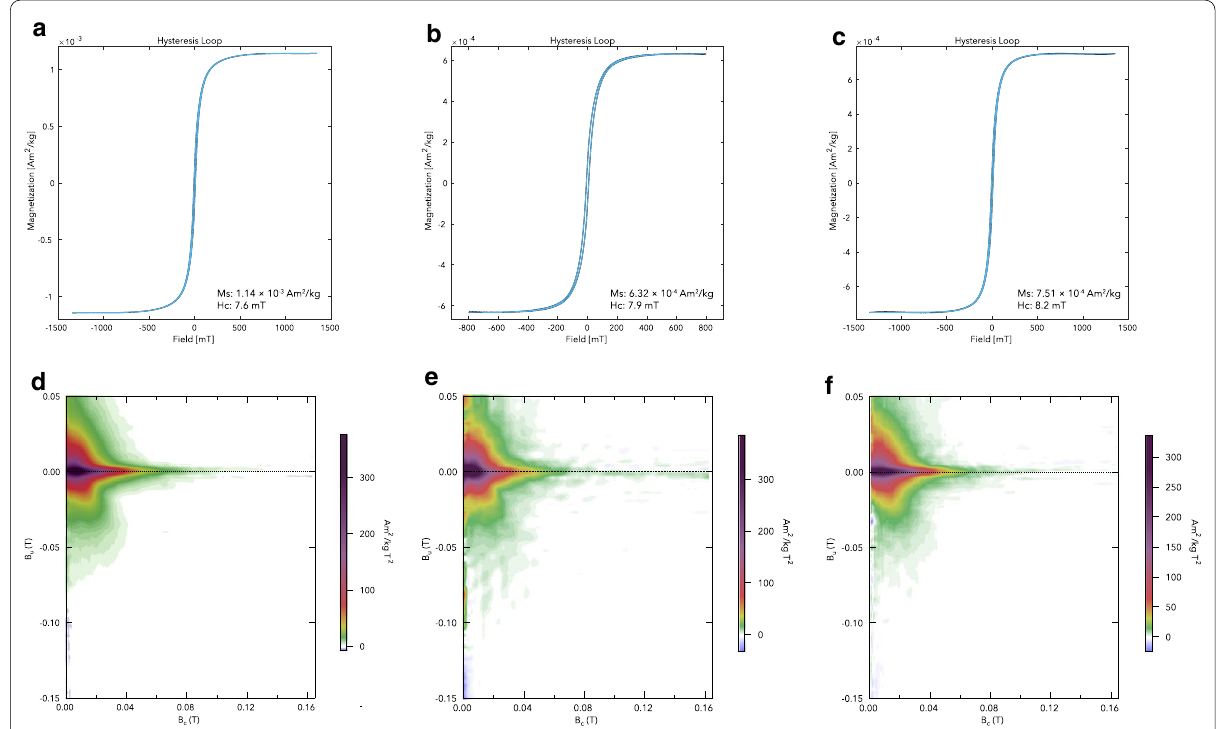
Fig. 5 Results of measurements with AGM for samples from the grayish section (AAC-B3), the white section (AAC-W3), and the mixture of gray layers and white part (AAC-M). Hysteresis loops of a AAC-B3, b AAC-W3, and c AAC-M, and FORC diagrams of d AAC-B3, e AAC-W3, and f